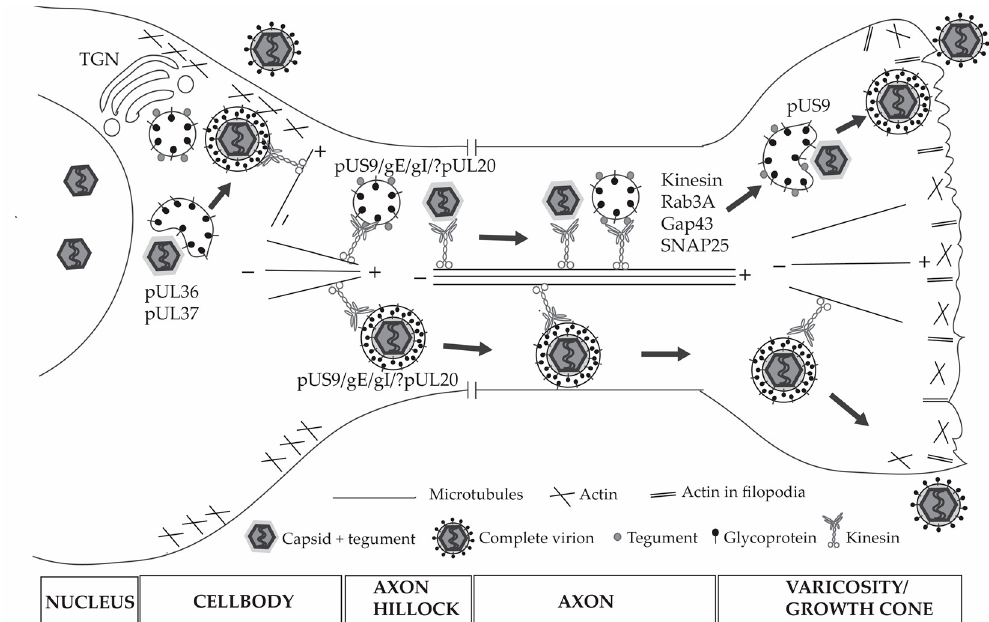
Figure 3. HSV-1 assembly, transport and exit from neurons. In the cell body, following nuclear egress, naked capsids acquire inner tegument proteins predominantly in the cytoplasm followed by the acquisition of outer tegument and envelope proteins as capsids invaginate vesicles derived from the TGN. The fully enveloped virion is transported to the plasma membrane where it can exit the cell body. Viral capsids containing inner tegument proteins with or without an envelope and vesicles associated with glycoproteins and tegument proteins are also targeted for active transport along microtubules in axons utilizing the neuronal secretory pathway (involving Rab3A, Gap43, SNAP25, and kinesin) and this process is mediated by the envelope proteins pUS9, gE/gI and possibly (?) pUL20. Viral capsids acquire a final envelope by invagination of vesicles with associated tegument and envelope proteins prior to exit from axonal growth cones.